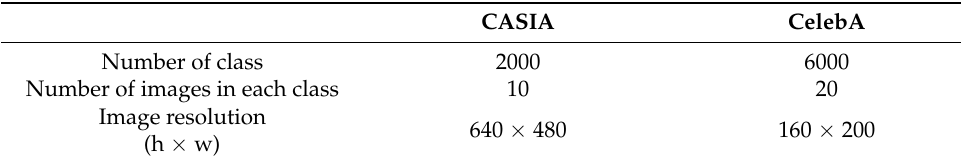
Table 2. Dataset